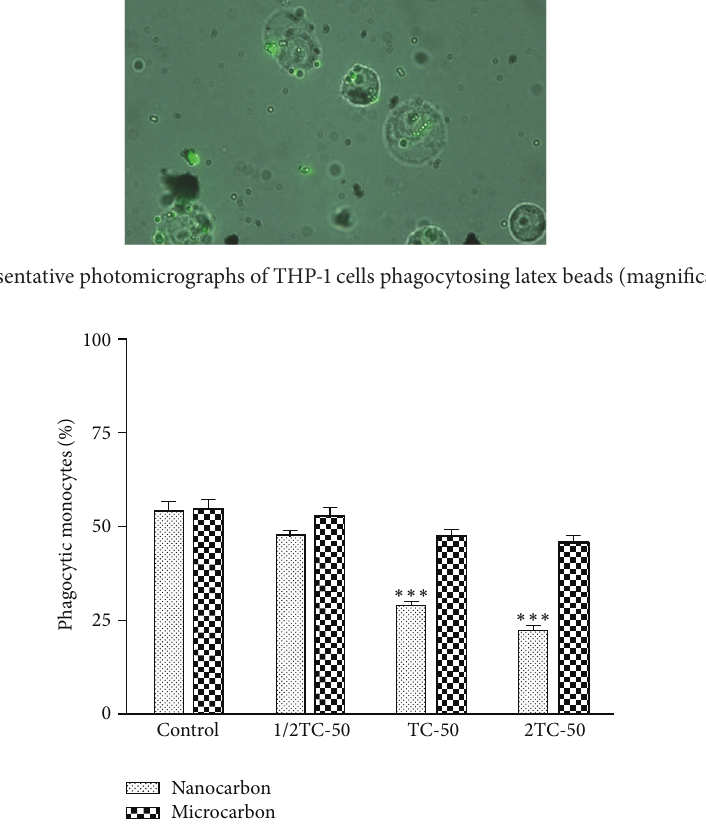
Figure 5: Percentage of cells capable of phagocytosing the indicator latex beads after the uptake of test particles (i.e., phagocytic monocytes). Cells were exposed to 1/2TC-50, TC-50, and 2TC-50 concentrations of nano carbon (295.7 𝜇 g/mL, 591.4 𝜇 g/mL, and 1182.8 𝜇 g/mL, resp.) and micro carbon (343.5 𝜇 g/mL, 687.1 𝜇 g/mL and 1374.2 𝜇 g/mL, resp.) for 4h. The results are expressed as a percentage relative to controls and are presented as mean ± SEM of three independent replicate experiments. Significance is indicated by ∗∗ 𝑃 < 0.01 versus